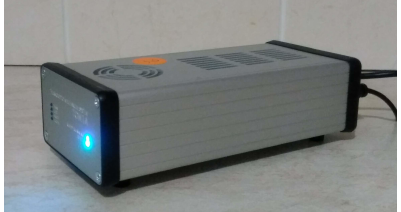
Figure 4. Arduino based thermo-opto-mechanical laboratory plant